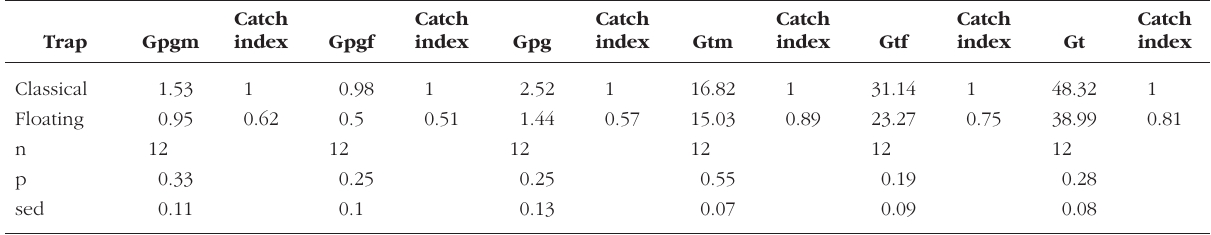
Table II. – Results of comparisons between the modified (floating) biconical trap and the classical one on the Comoe river in Burkina